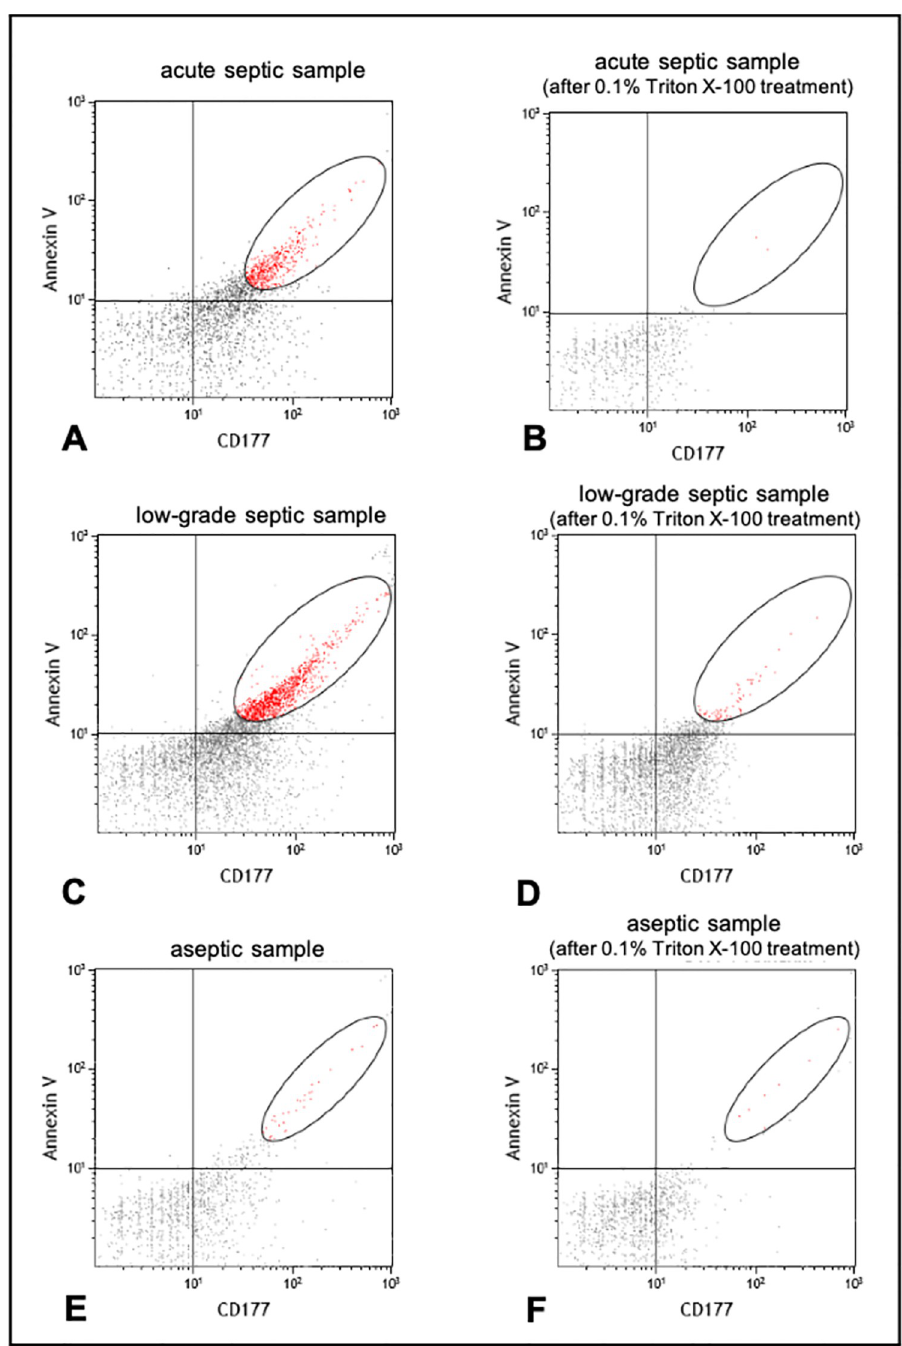
Fig 5. Dot plots depict the FC analysis of acute septic (A) low-grade septic (C) and aseptic (E) samples labelled with annexin V and CD177 surface markers. After 0.01% Triton X-100 detergent lysis (B,D,E) real vesicular events disappear. The difference in the FC event numbers before and after detergent lysis represents the true number of EVs. The oval gates show the size range of the EVs.